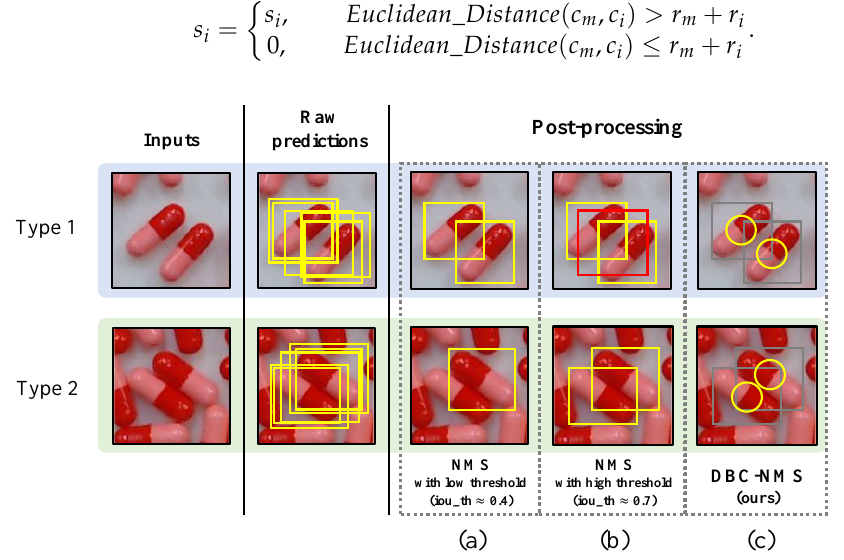
Figure 2. EffectsofNMSbyIoUthresholdandDBC-NMS ( a ) NMS results with low threshold for raw predictions. ( b ) NMS results with high threshold for raw predictions. ( c ) DBC-NMS results for raw predictions.